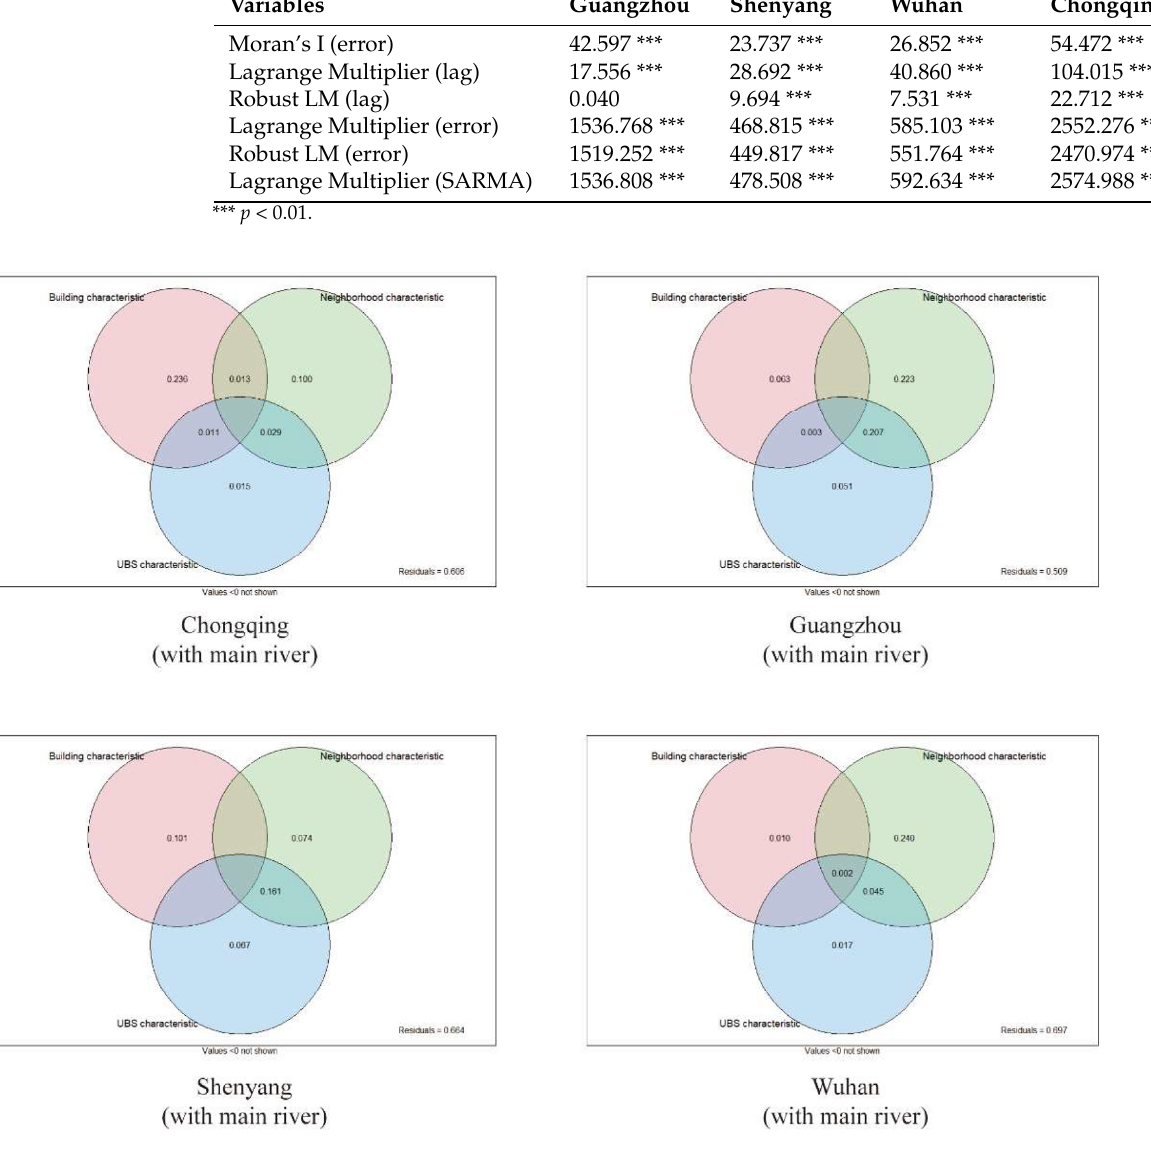
Figure A2. Variance partitioning analysis results for Model II.